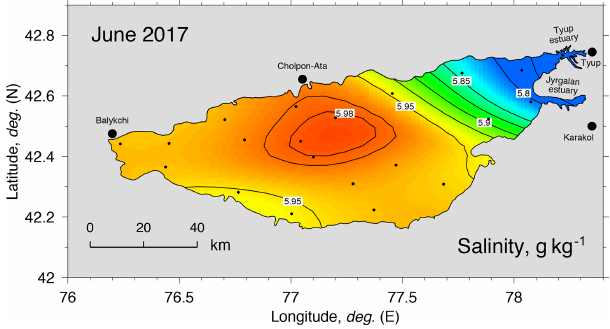
Figure 5. Salinity at lake surface in June 2017, based on data from hydrographic stations indicated by